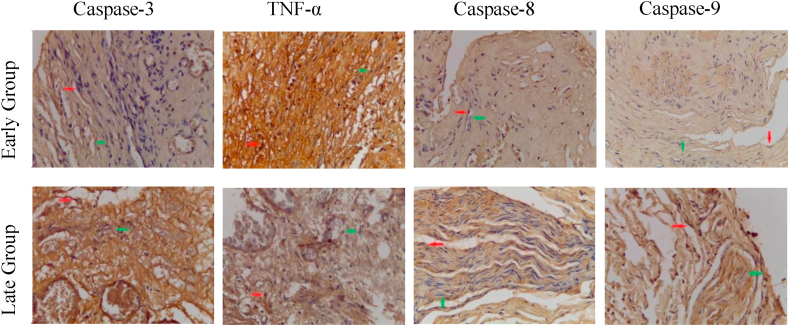
Immunohistochemistry staining of Caspase-3, TNF-α, Caspase-8, and Caspase-9 expression on brachial plexus proximal stump, in the early group and late group. 400x magnification. (Red arrow = IHC positive cell. Green arrow = IHC negative cell). (For interpretation of the references to colour in this figure legend, the reader is referred to the Web version of this article.)